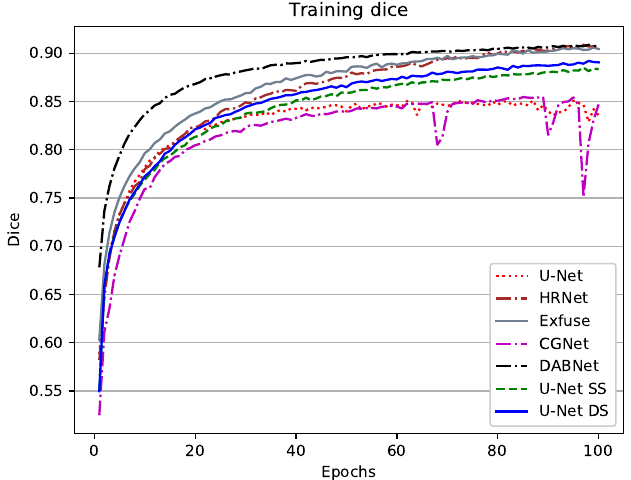
Figure 10. Comparison Dice function (F1 score) of the during the training.